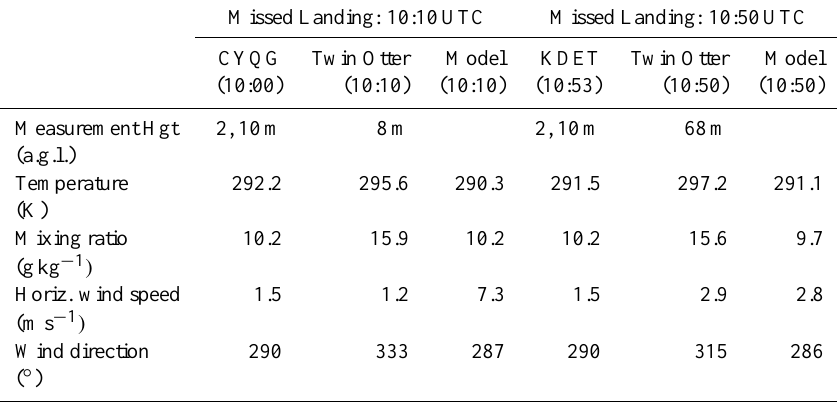
Table 3. Measurements and model estimates for two missed landing maneuvers during Twin Otter Flight #13, 7 July 2007. Airport measure- ments (CYQG, KDET) are taken from METAR, with scalar quantities measured at 2ma.g.l. and wind measured at 10ma.g.l. The height of Twin Otter measurements is a 1-min average. Model estimates are interpolated to the averaged Twin otter measurement